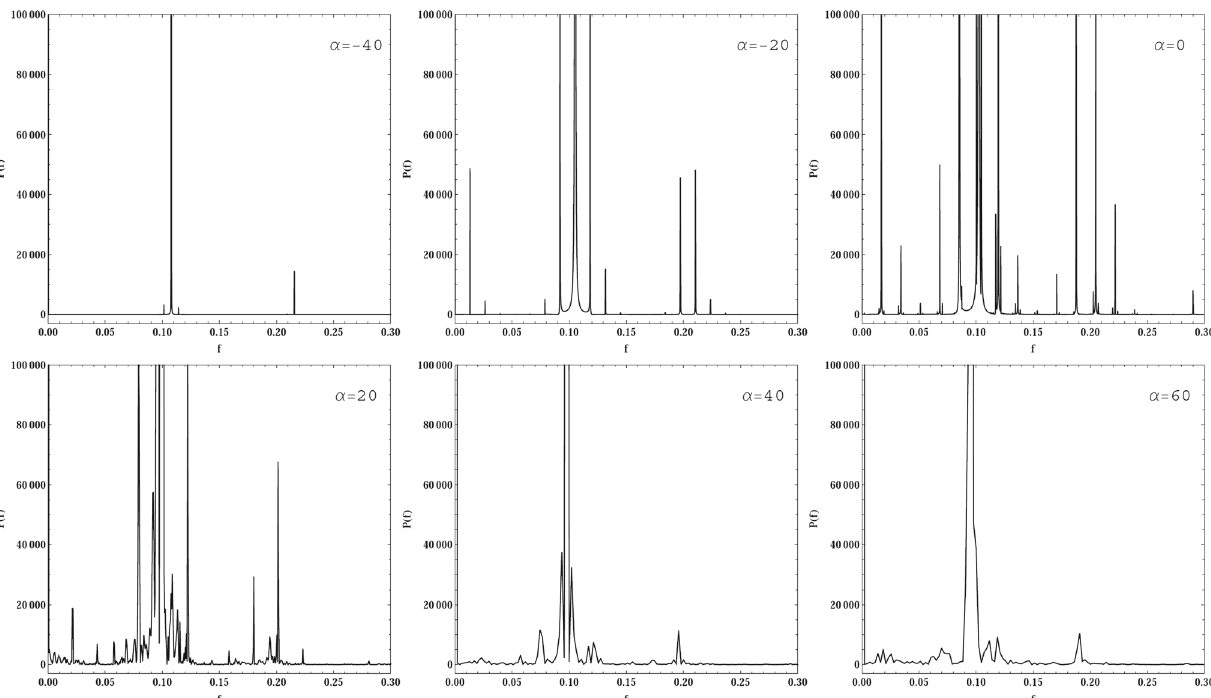
Fig. 2 The power spectrum of the solutions for different α with a set of parameters ( E = 0 . 99, L = 3 . 9, m = 1, B = 0 . 02) and initial conditions